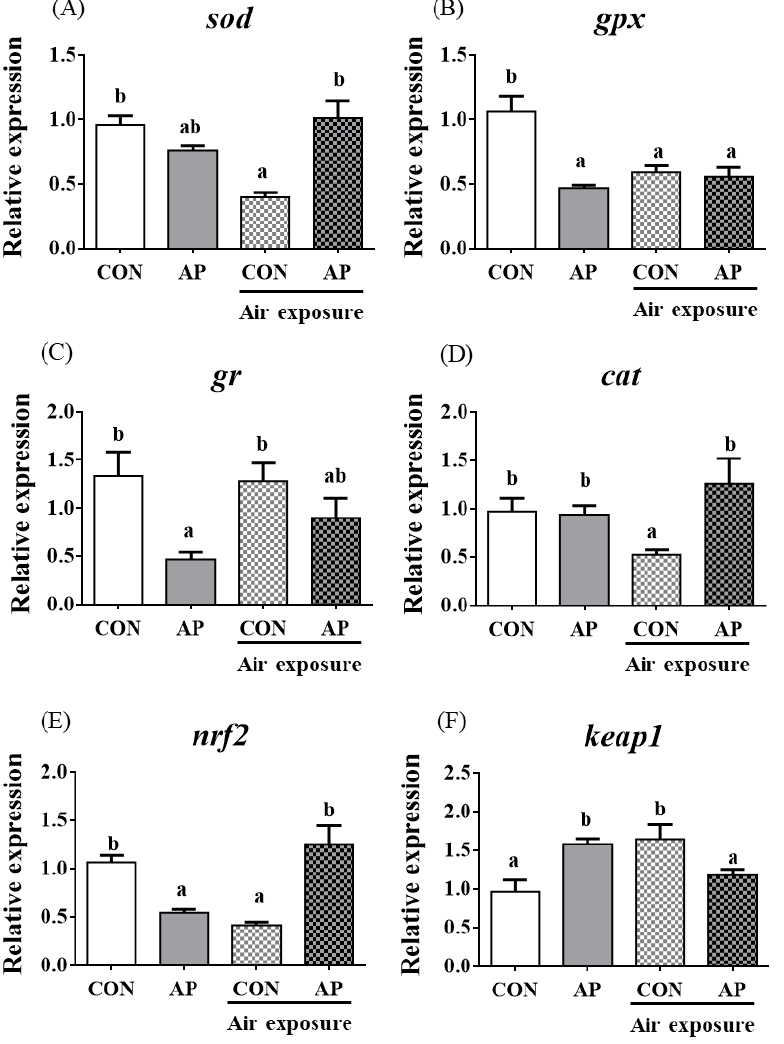
Figure 4. sod ( A ), gpx ( B ), gr ( C ), cat ( D ), nrf2 ( E ), and keap1 ( F ) gene relative expressions levels of kidney in the two groups before and after air exposure stress. Data are indicated as mean ± SEM ( n = 6). Bars with different lowercase letters mean significant differences among groups ( p <